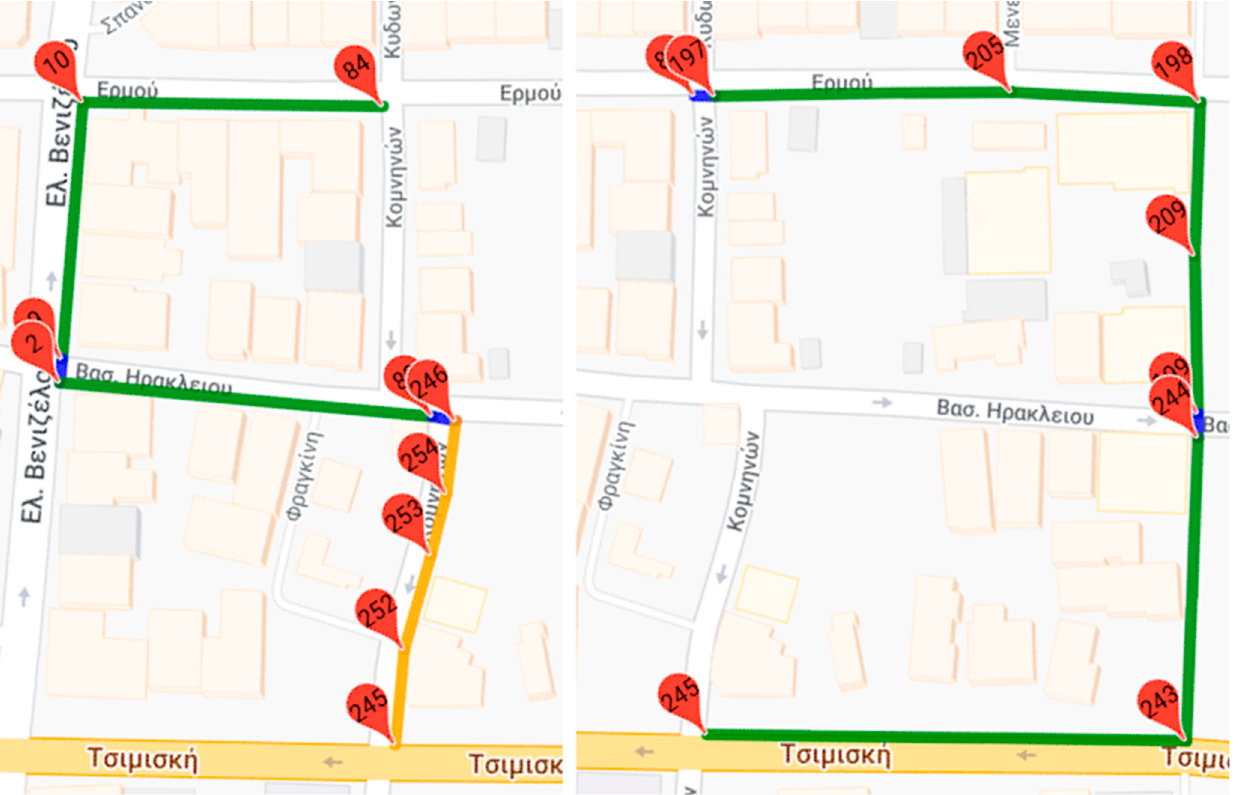
Figure 2. Shortest ( left ) and most accessible ( right ) path between nodes 84 and 245. Table 1. k-shortest paths for use case I.